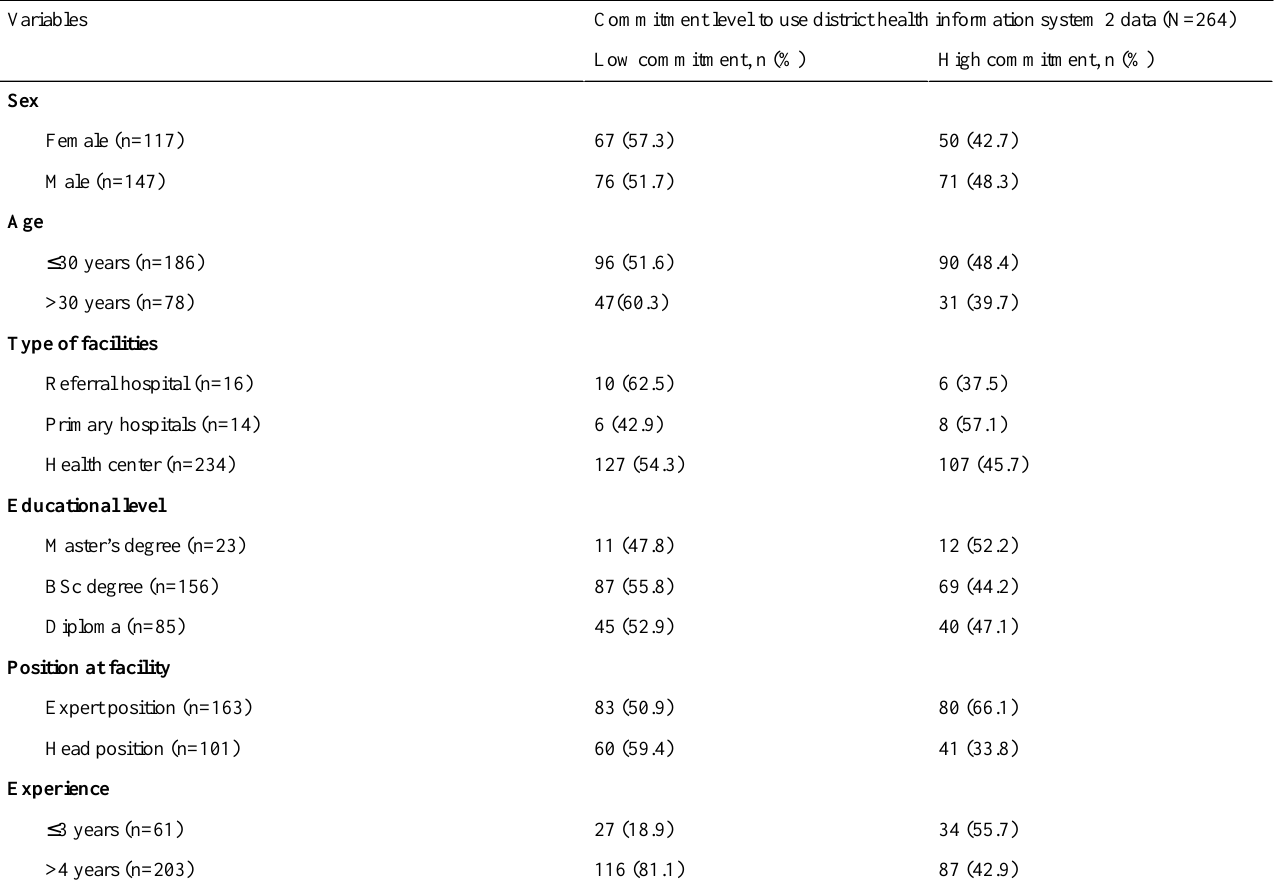
Table 2. Commitment levels of the performance monitoring team members to use district health information system in accordance with the sociodemographic characteristics a